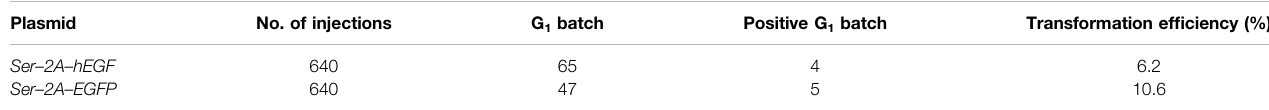
TABLE 1 | Transformation ef fi ciency of transcription activator-like effector nuclease (TALEN)-mediated transformation. Note. A total of 640 preblastoderm stage embryos were injected for each strain of animals.